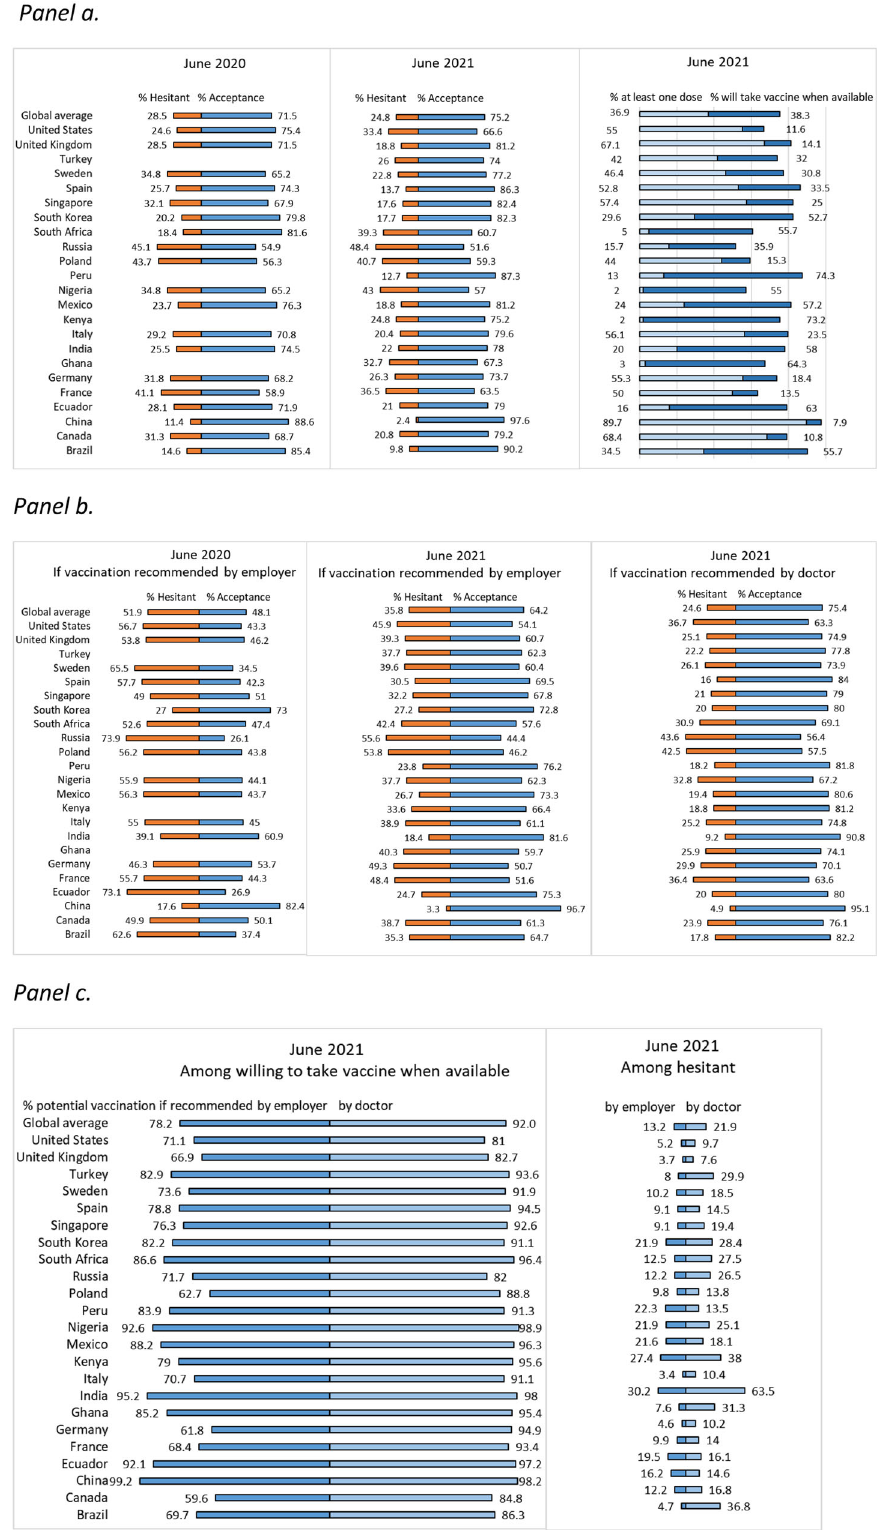
hesitancy was observed in countries with vaccine uptake of greater than 40% of the population, with the exception of Poland, France, and the US, which had higher hesitancy. Parents ’ hesitancy to vaccinate their children was repored most often in Russia (64.5%), Poland (53.7%), and France (51.1%) and least often in China (5%), Brazil (8.7%), Ecuador (14.1%), and Peru (14.9%). In all